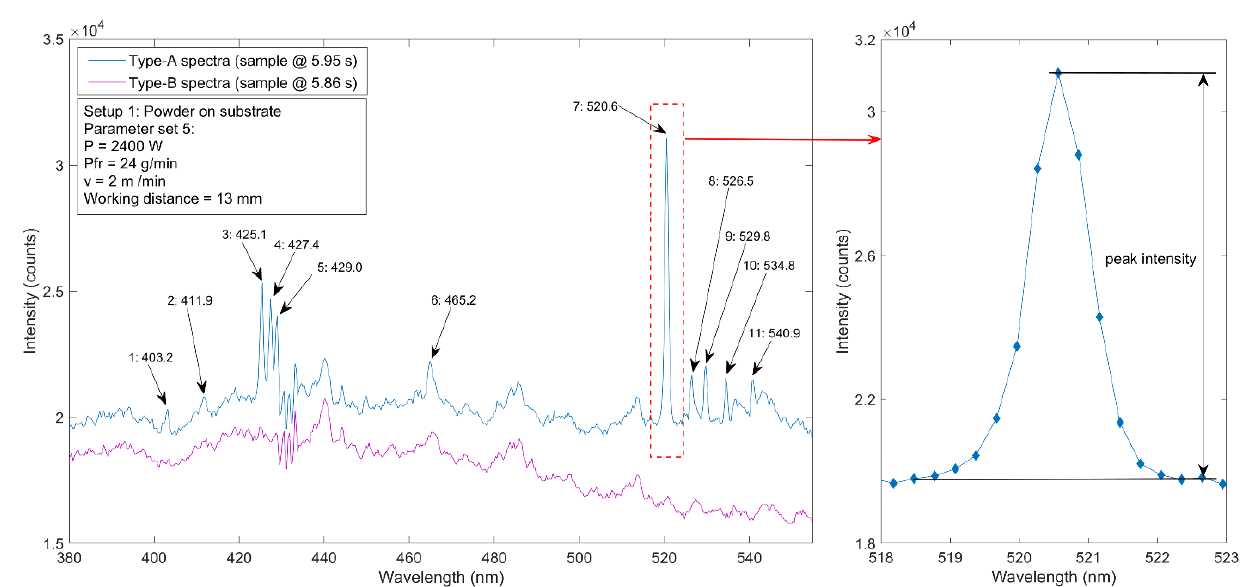
Figure 6. Identification of element lines via the evaluation of a single spectrum taken under the experimental conditions of setup 1 and parameter set 5 as defined in Figure 3 and Table 1.